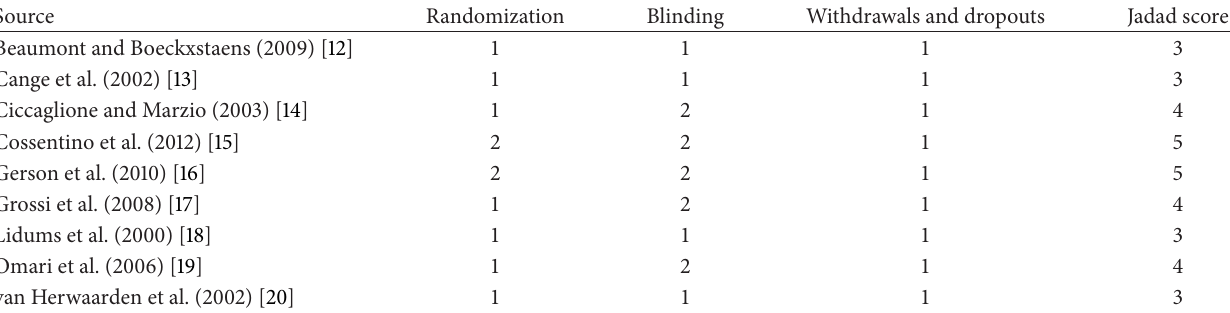
Figure 1: Flow diagram showing the procedure for the systematic review of studies for meta-analysis. Table 2: Quality assessment of RCTs in this